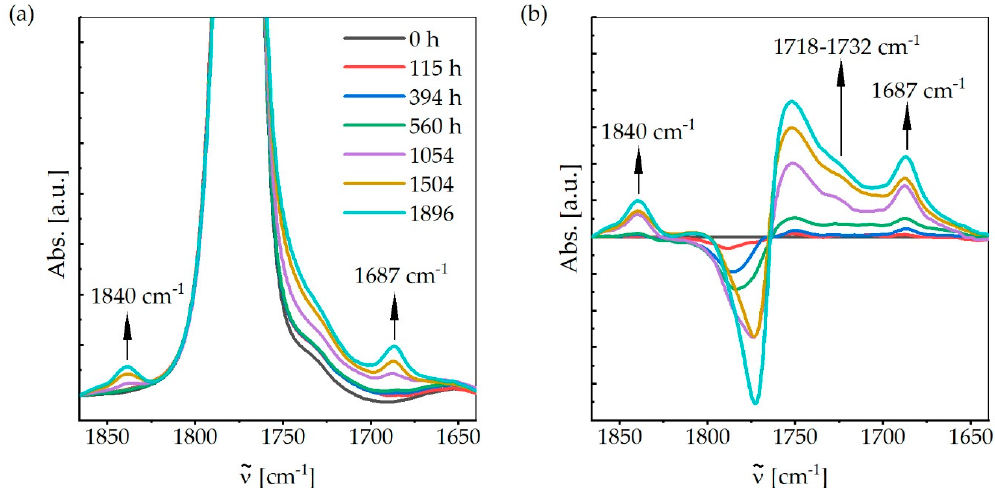
Figure 13. IR-spectra from 1640 to 1890 cm − 1 after different aging times: ( a ) carbonyl region from 1640 to 1890 cm − 1 ; and ( b ) IR-spectra compared to the spectrum of the unaged samples.